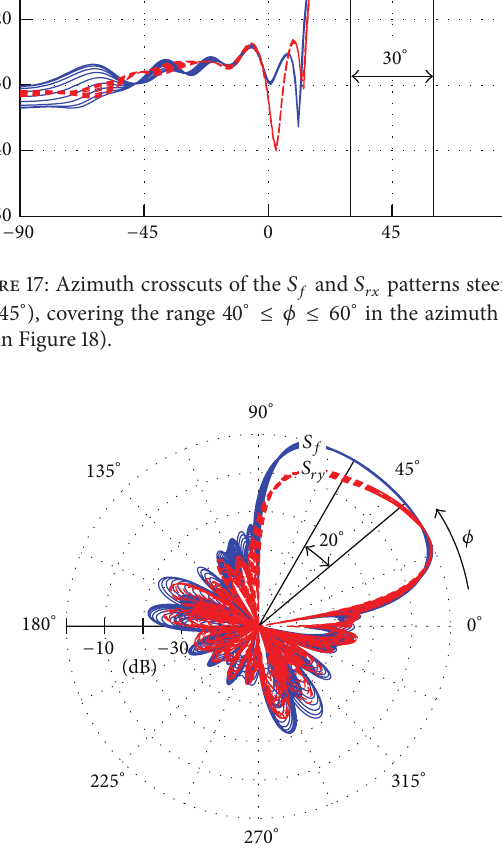
Figure 18: Elevation crosscuts of the 𝑆 𝑓 and 𝑆 𝑟𝑦 patterns, steered to (50 ∘ , 45 ∘ ) and covering the elevation range 30 ∘ ≤ 𝜃 ≤ 60 ∘ ( 30 ∘ in Figure